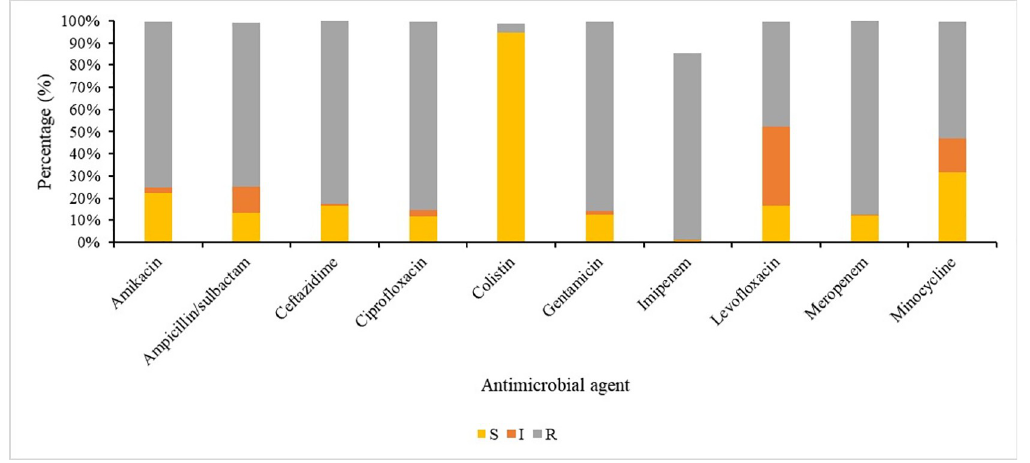
Fig 2. Antimicrobial susceptibility patterns of Acinetobacter baumannii complex (ABC) bloodstream isolates from South Africa from 1 April 2017 to 30 September 2019, n = 2033. Susceptible (S), Intermediate (I) and resistant